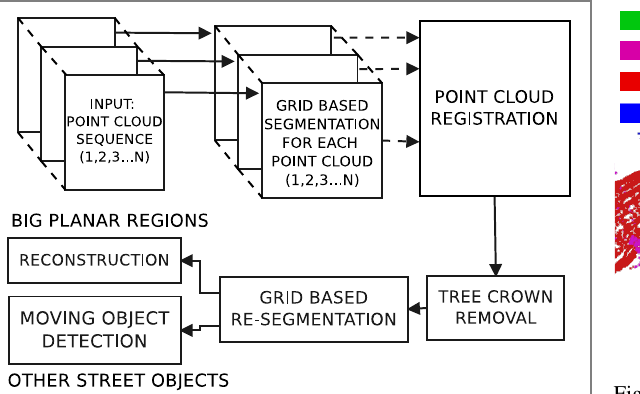
Figure 1: The workflow of the proposed algorithm tor but requires a computationally expensive principal component analysis (PCA) calculation.